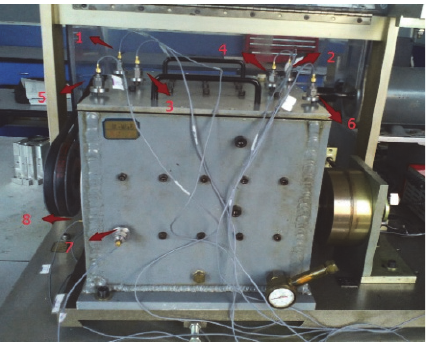
Figure 9: Sensor